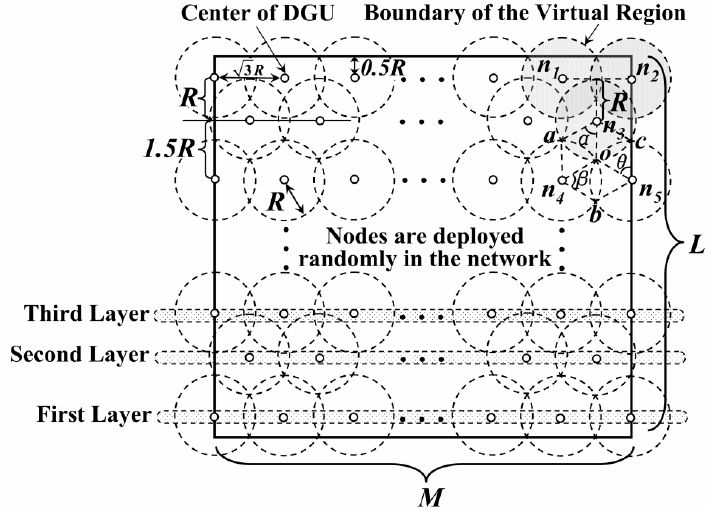
Figure 1. Data gathering unit in the network.